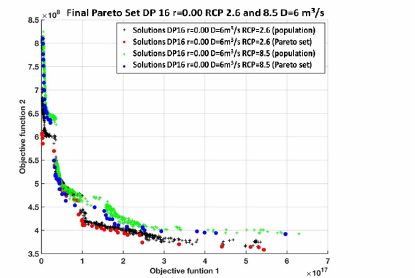
Figure 15. Pareto set for scenario 3 of Table 2.